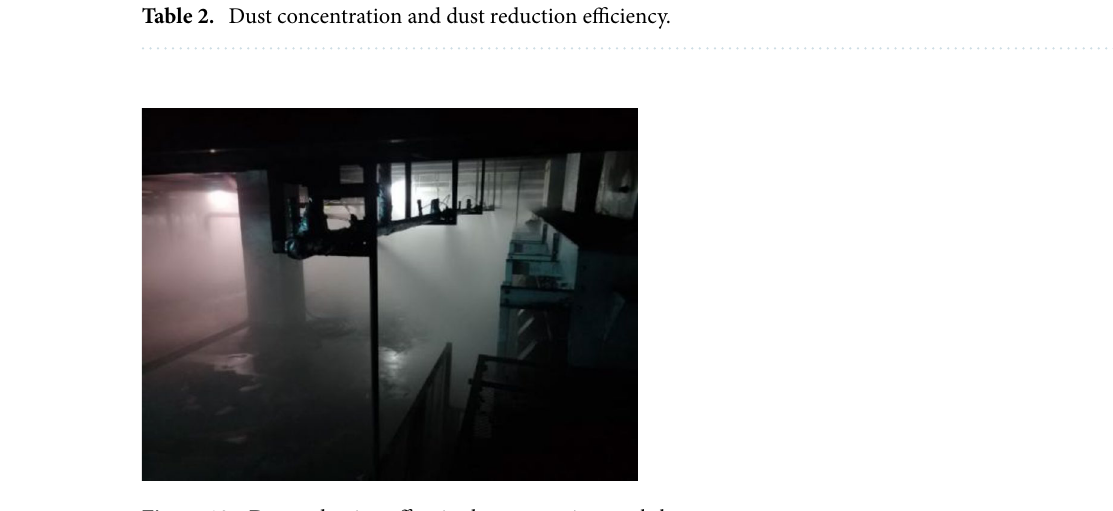
Figure 12. Dust reduction effect in the preparation